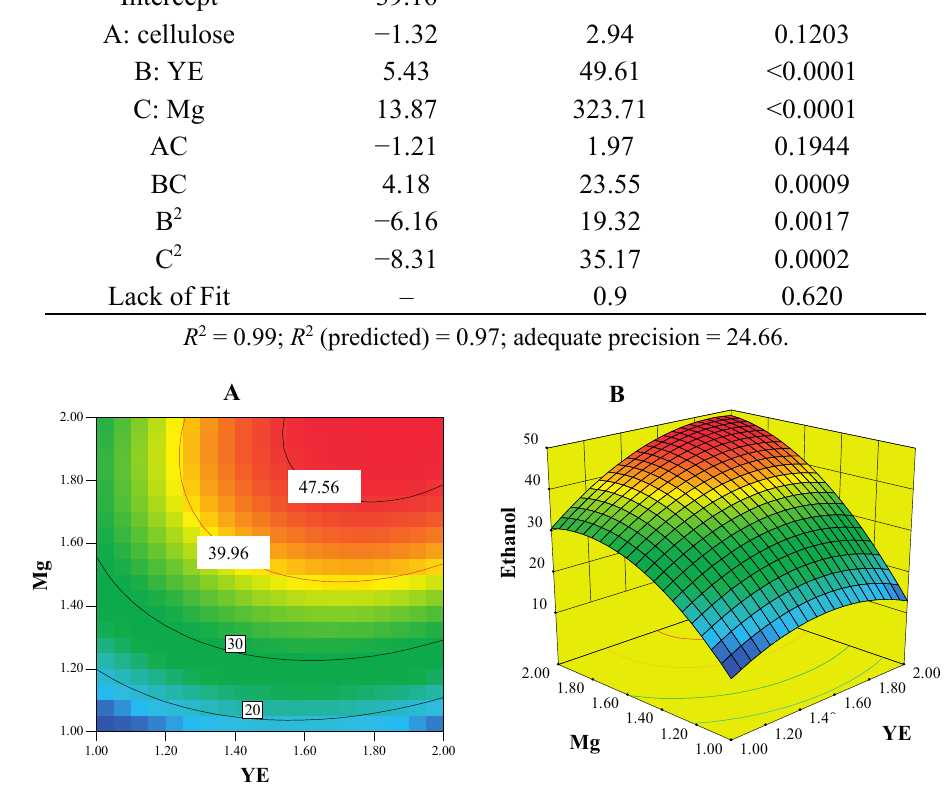
Figure 3. Contour ( A ) and surface ( B ) plots of ethanol-concentration (mmol/L) model show the interactions between YE and Mg when the level of cellulose was held constant at 30